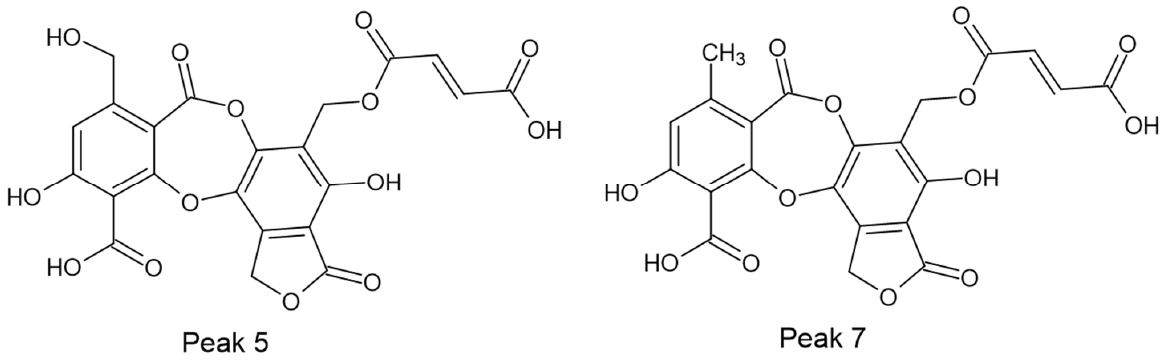
Figure 1. Chemical structures of new compounds ( 5 and 7 ) identified by UHPLC/ESI/MS/MS from C. metacorallifera . It proposes interconversion mediated by natural oxidation from peak 13 (fumarprotocetraric acid) to peak 7 and after to peak 5, as supported by mass spectrometry and UV spectroscopy.